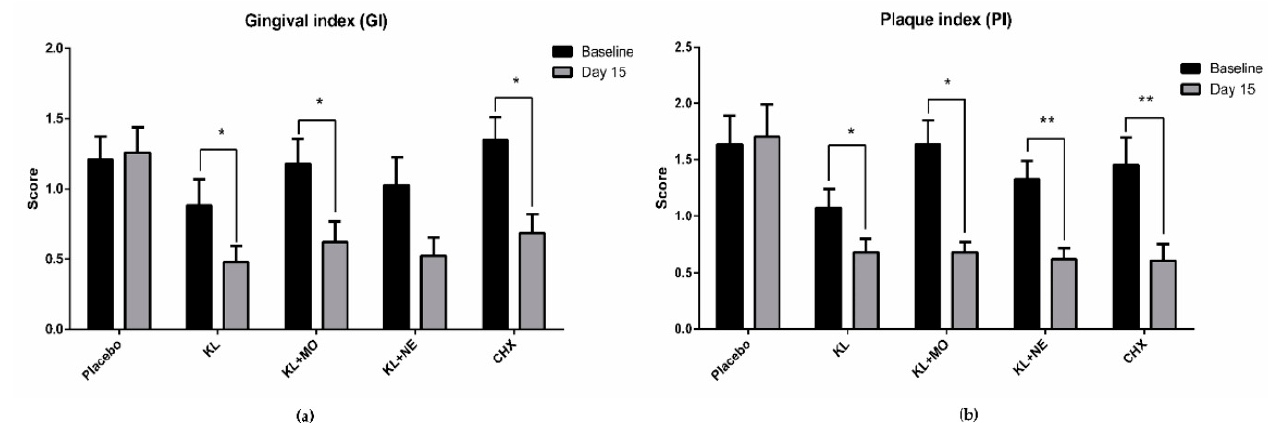
Figure 4. Intragroup comparison of gingival index ( a ) and plaque index ( b ) scores between baseline and day 15 after